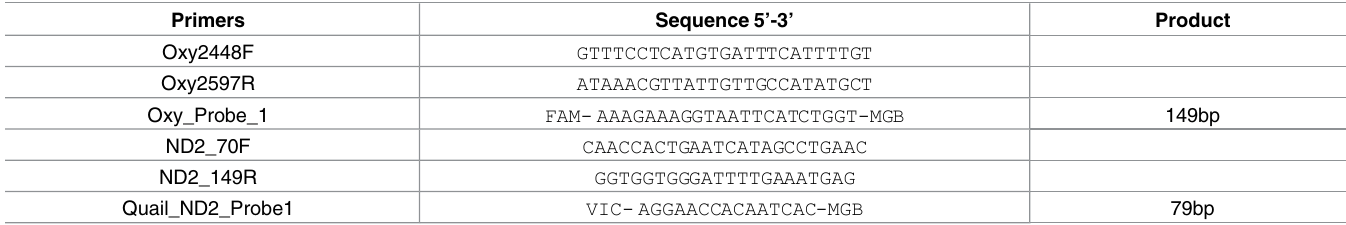
Table 1. Primers and hydrolysis probes analyzed for quantitative PCR for Oxyspirura petrowi detection.